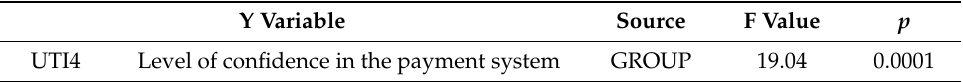
Table 3. Model with UTI4 “Level of confidence in the payment system”.